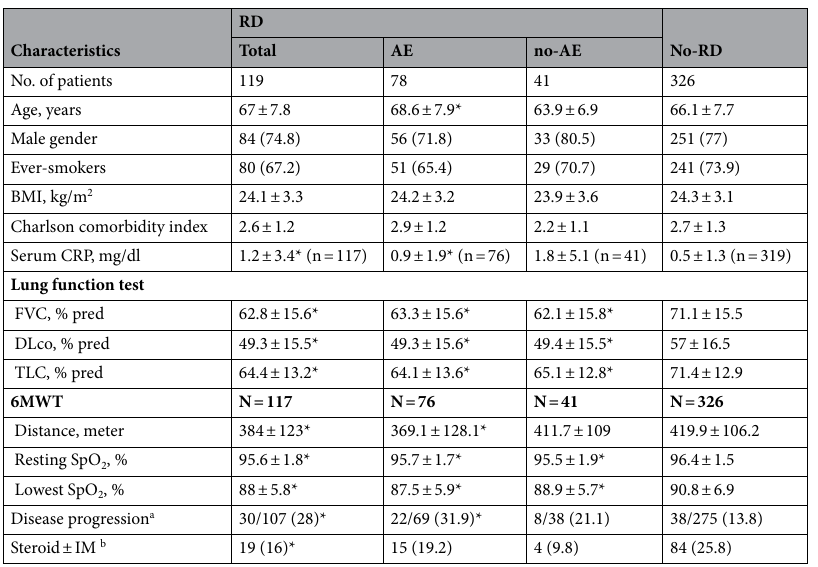
Table 1. Comparison of the baseline characteristics between IPF patients with acute respiratory deterioration and those without. Data are expressed as a mean ± standard deviation or a number (%) unless